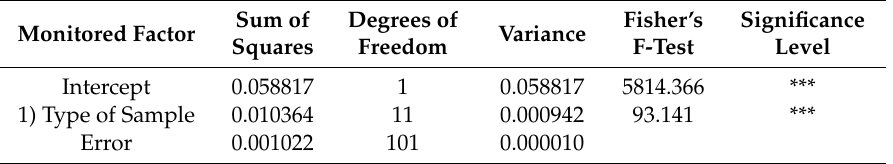
Table 4. Statistical evaluation of the e ff ect of the factors and their interaction on the coe ffi cient of wood bendability ( K bendC ) for aspen and NWC on top.